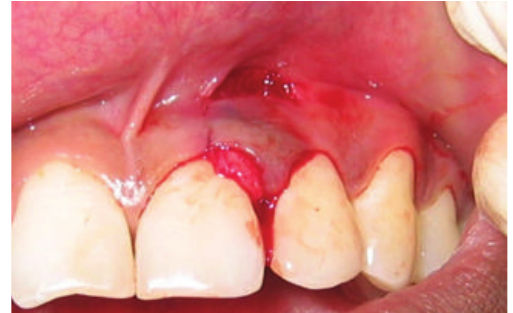
Figure 13: Incisions given for the removal of